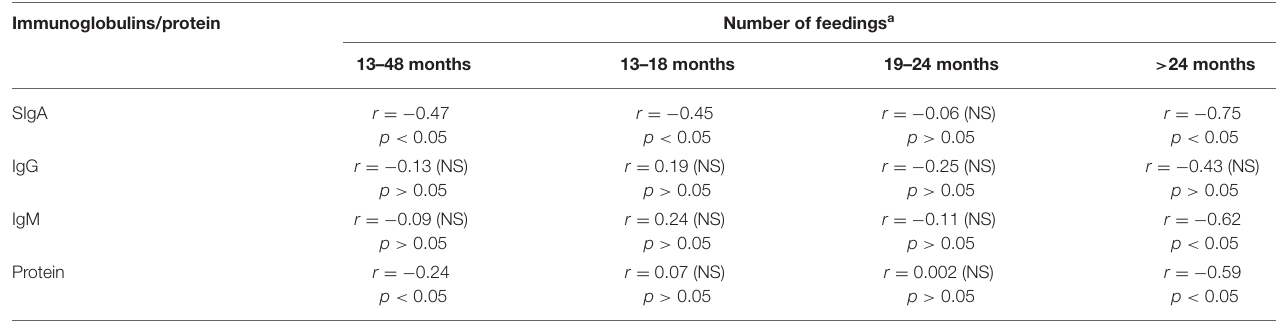
TABLE 4 | Relationship between number of feedings and immunoglobulin or protein concentration in breast milk during prolonged lactation.